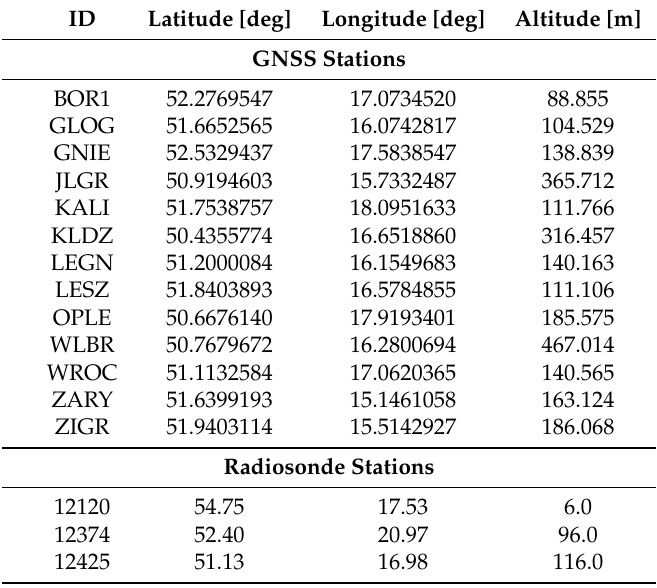
Table A1. Coordinates of GNSS and radiosonde stations used in the analysis. The altitude corresponds to the geometric height above the